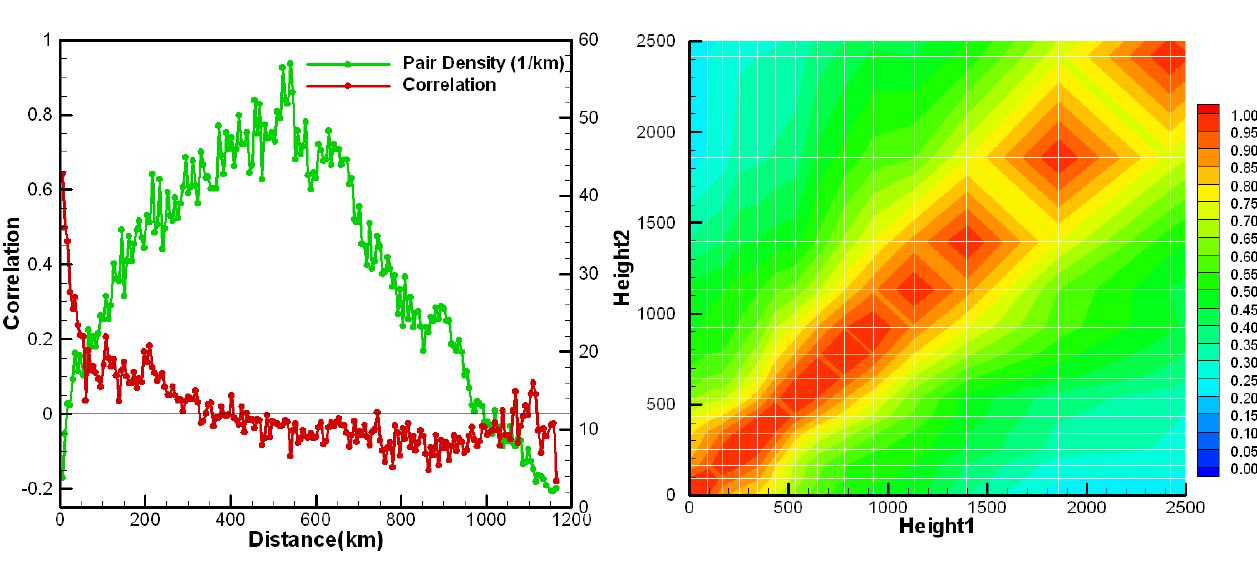
Figure 2. Ozone error statistics results through Hollingsworth-Lönnberg approach. AIRNow observations are used to get horizontal error statistics (left). Ozonesonde observations are used in calculating vertical model error statistics (right). Unit of height: